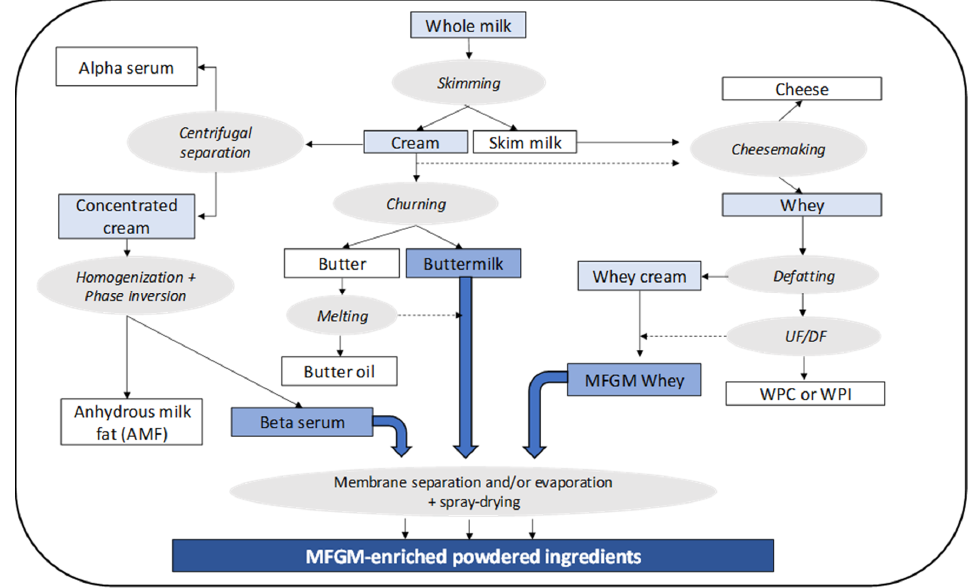
Figure 1. Processing alternatives to produce milk fat globule membrane (MFGM)-enriched powdered